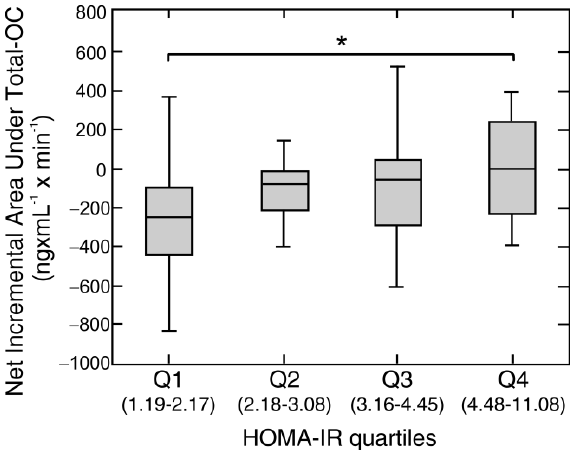
Figure 5. Net incremental areas under total-OC and quartiles of the Homeostatic Model Assessment of Insulin Resistance (HOMA-IR) index. Variation of values of net incremental areas (Net AUC) under total osteocalcin (Total-OC) during a high fat mixed meal tolerance test with the quartile of the HOMA-IR (range of values for each quartile is in brackets) in combined non-obese ( n = 24) and obese ( n = 70) subject study groups. Values are presented as medians (line), upper and lower quartile (box), and extremes (whiskers). Statistics: Kruskal-Wallis and Dunn test. Significant differences are indicated as follows: * p < 0.05.